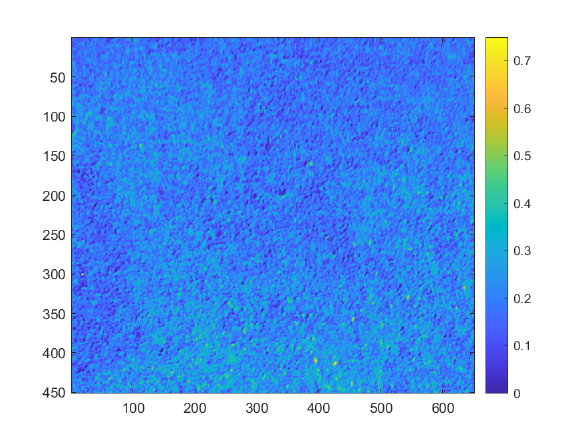
Figure 8. Degree of linear polarization at starting time, right after forming the